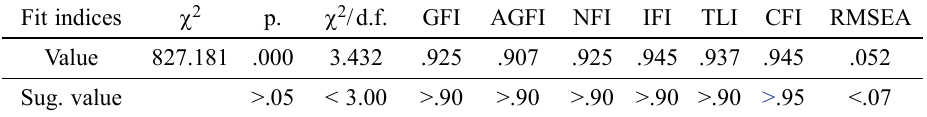
Fig. 2. The EB of Choice model Table 3. Summary of fit indices of the